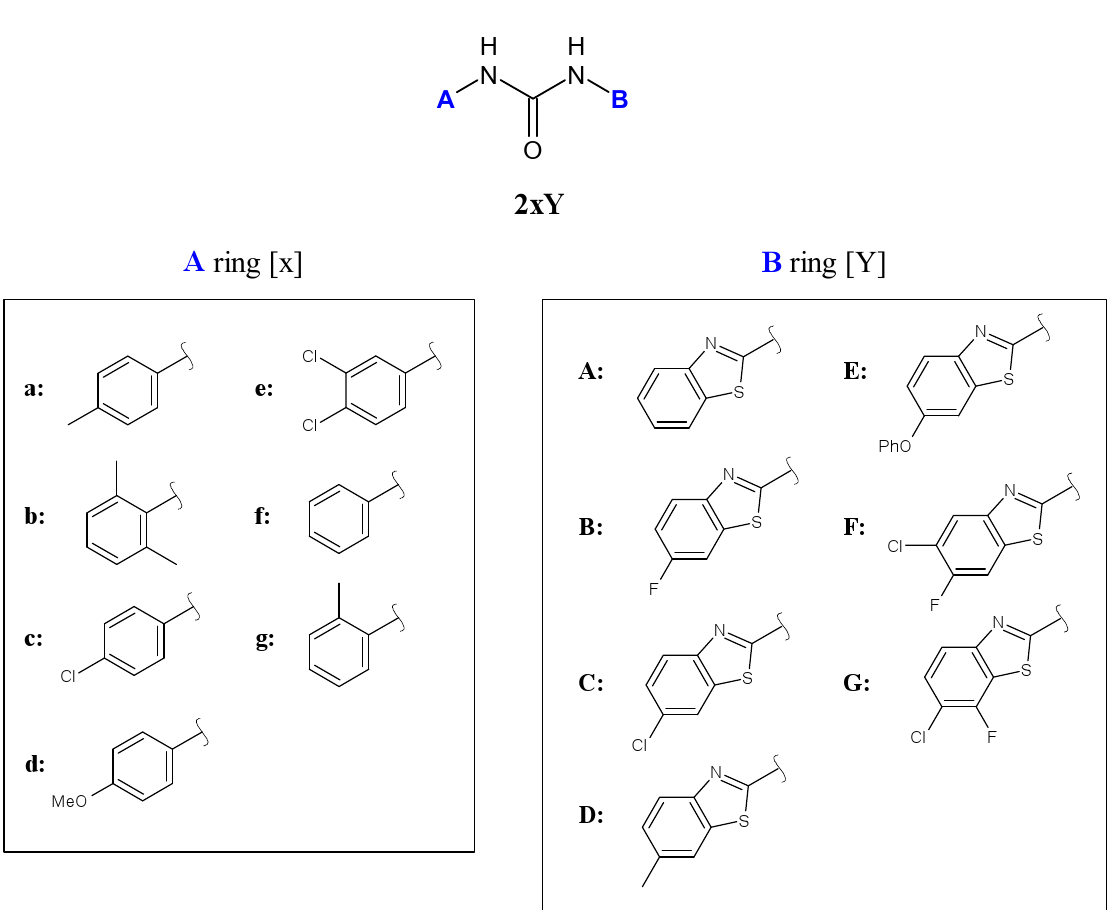
Figure 3. Library composition of diarylureas 2 [x,Y].